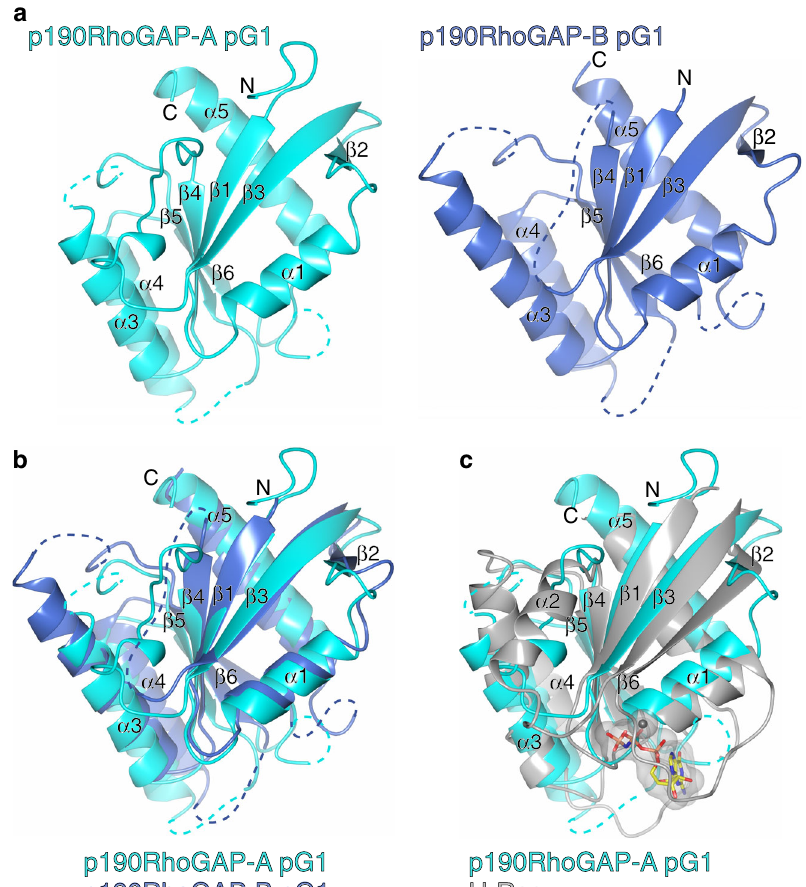
Fig. 2 Structural analysis of p190RhoGAP pseudoGTPase domain pG1. a Crystal structures of pG1 for p190RhoGAP-A ( left , cyan ) and p190RhoGAP-B ( right , blue ). Secondary structure and N and C termini are labeled. Unmodeled loops are indicated by a dashed line . b Superposition of p190RhoGAP-A and -B pG1 domains. c Superposition of p190RhoGAP-A pG1 domain with GTP-analog bound H-Ras in gray ; PDB ID: 5P21